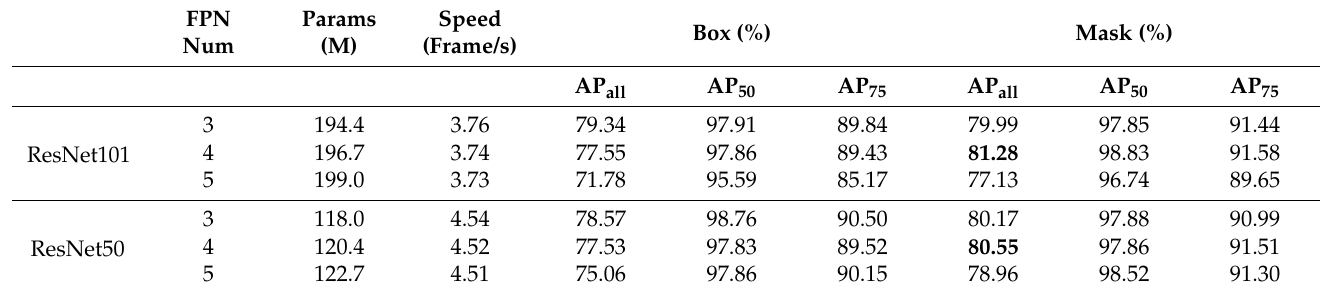
Table 3. Performance of YOLACT network with different parameters on the polished rice dataset.